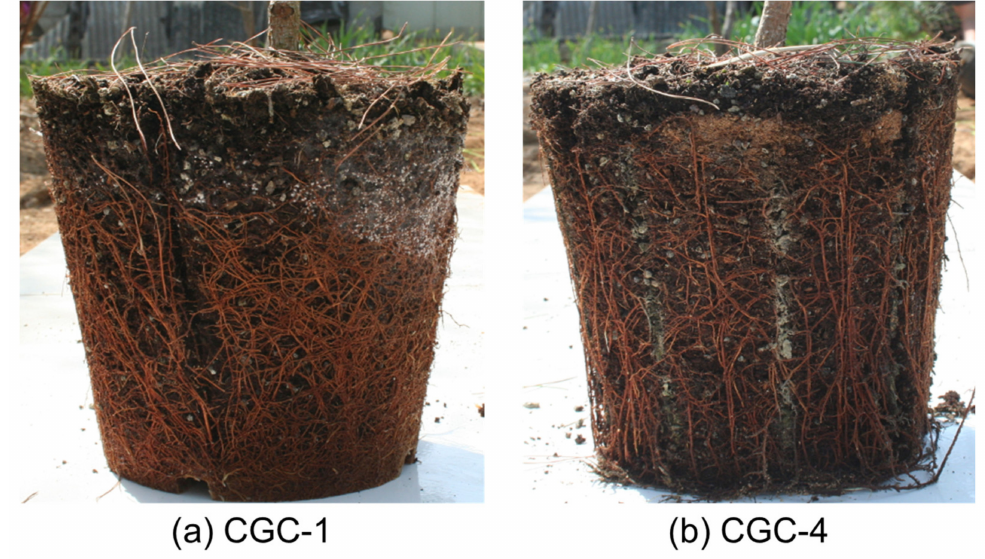
Figure 5. Pinus densiflora seedling root status a ff ected by CGCs. In CGC-1 ( a ), the roots grew in a spiral shape, whereas the roots in CGC-4 ( b ) grew vertically.